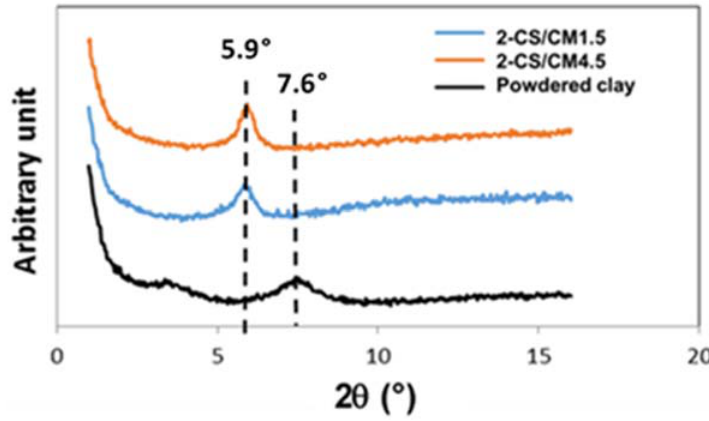
Figure 4. X-ray diffraction patterns of the clay sample and the clay containing hybrid beads .